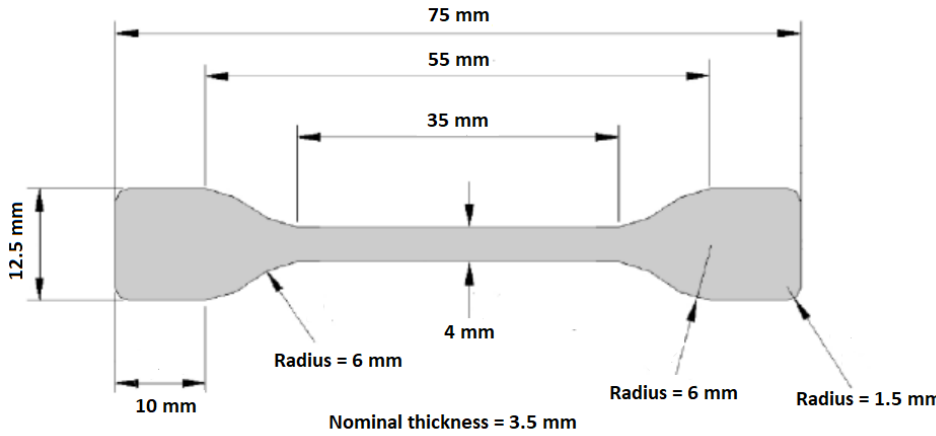
Figure 1. Sample mold’s nominal dimensions.